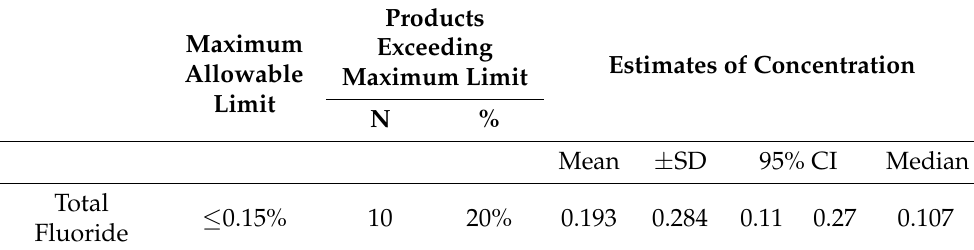
Table 2. Descriptive Statistics of Total Fluoride in Toothpaste Products ( n = 50).